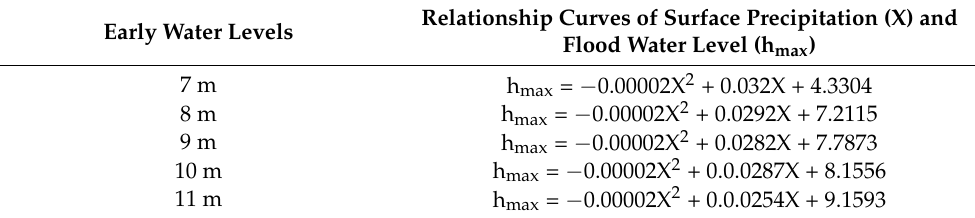
Table 3. Relationship curves of the surface rainfall and flood water level at Longtang station in Haikou City for different early water levels. Relationship Curves of Surface Precipitation (X) Early Water Levels